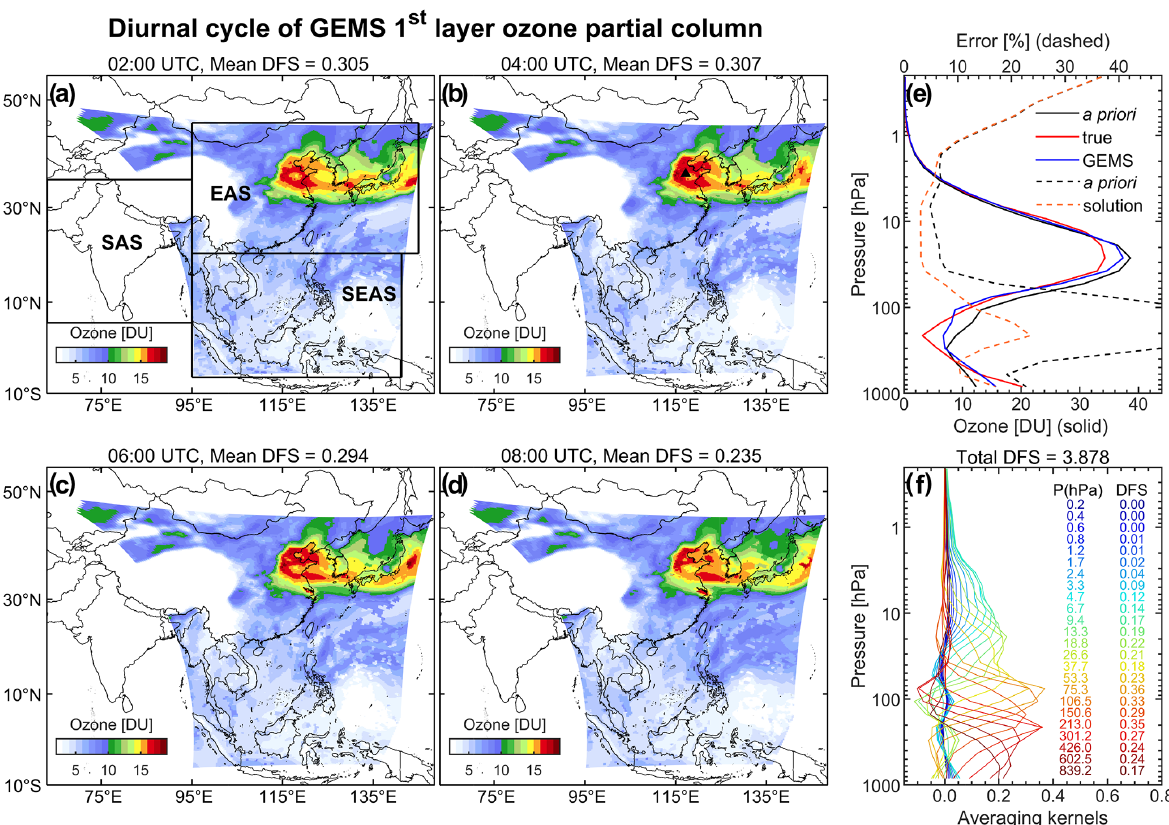
Figure 1. Example of diurnal cycles of surface-layer ozone partial column (02:00, 04:00, 06:00, and 08:00UTC, a–d ), vertical ozone profiles and relative retrieval errors (e) , and averaging kernels (f) at 04:00UTC for a specified grid with high ozone level (36.6 ◦ N, 117.1 ◦ E, denoted using the black triangle in b ) from simulated GEMS retrievals on 16 June 2020. In (a–d) , captions give the regional average of the degree of freedom for signal (DFS; defined as the trace of the averaging kernel matrix in Sect. 2.2) of the corresponding GEMS retrievals. The black box areas in (a) define the regions of East Asia (EAS), Southeast Asia (SEAS), and South Asia (SAS). In (e) , the solid lines denote the a priori (black), true (red), and retrieved (blue) profiles. The dashed lines represent the a priori (black) and solution (orange) errors that both normalized to a priori profiles. In (f) , the caption gives the total DFS. Averaging kernels (coloured by layers) are normalized to the thickness of each layer and a priori errors. Also inserted are elements of the DFS vector along with the central pressure of each